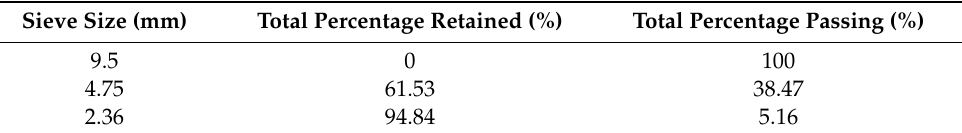
Table 2. Size distribution of aggregates.